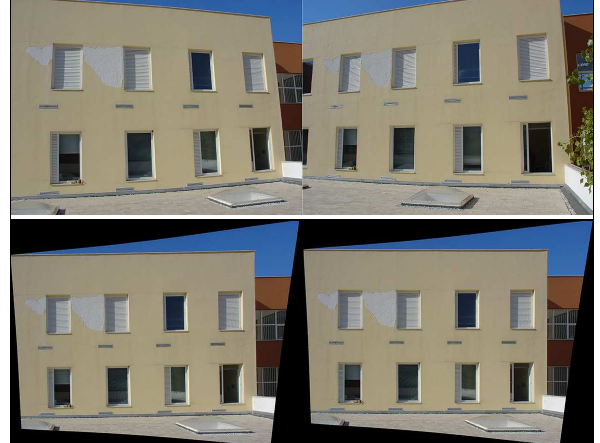
Figure 7. Rectified and rotated left image of the above pair (image axes convergence of 32º).